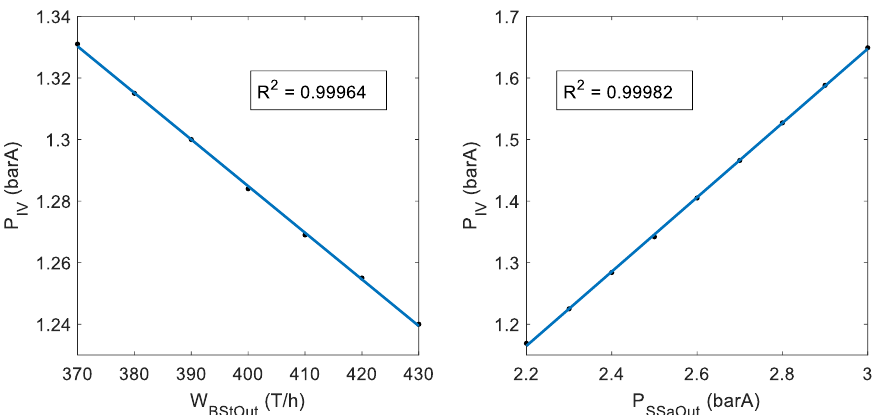
Figure 6. Experiments carried out to show linearity dependence between P IV and W BStOut ( left ) and P SSaOut ( right